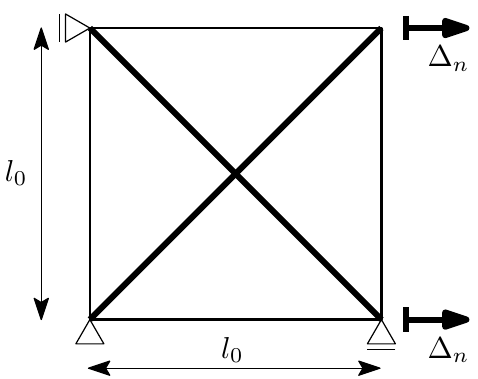
Figure 3. The geometry of unit lattice used for calibration of elastic properties and traction-separation